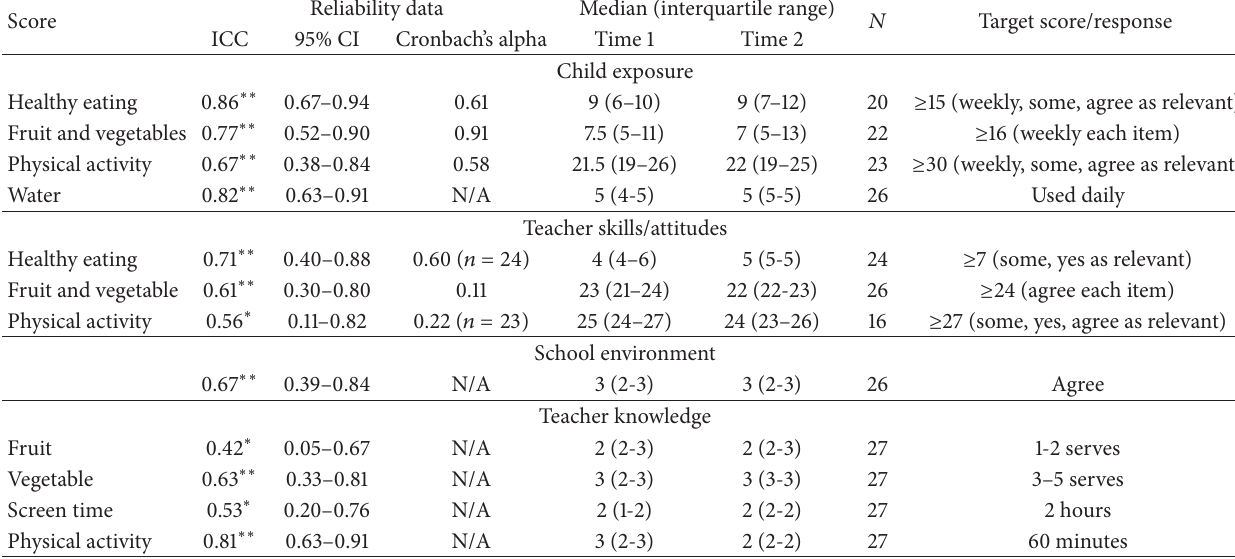
Table 4: Reliability demonstrated by intraclass correlation coefficient (ICC) and 95% confidence intervals (CI) for the teacher outcomes and internal consistency for the teacher